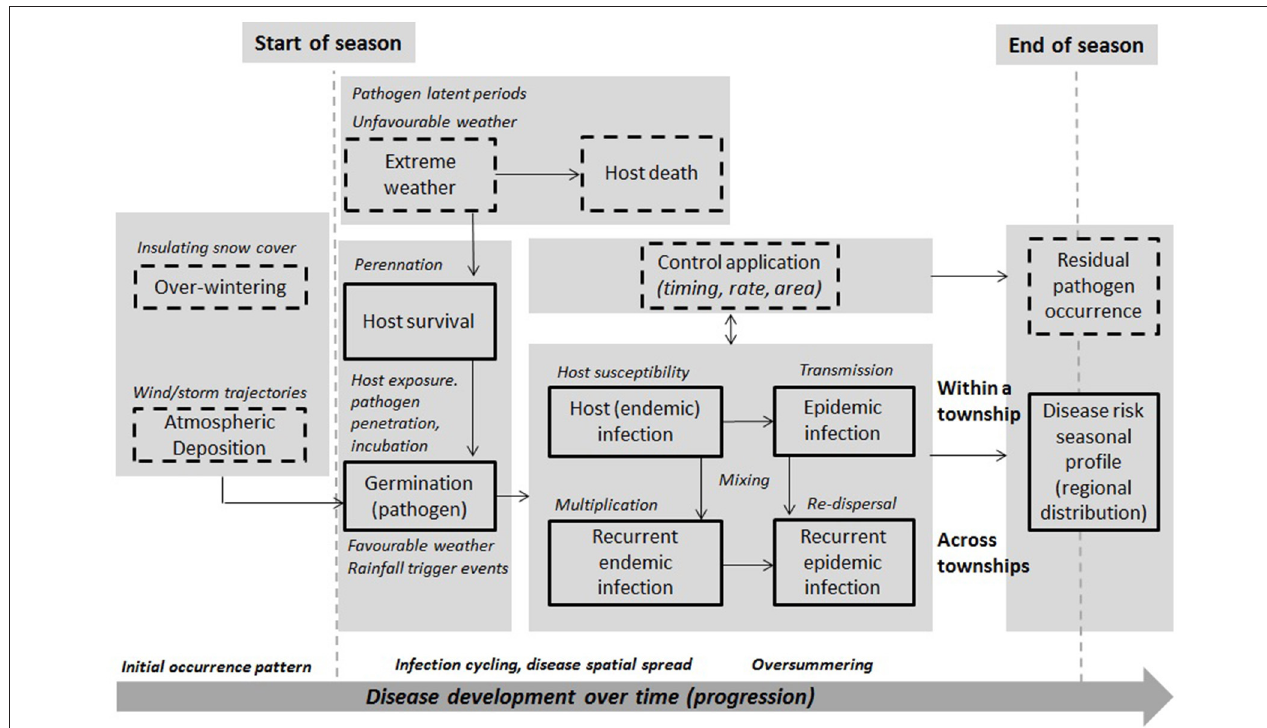
FIGURE 1 | A prototype integrated, model-based framework for forecasting disease risk. Risk components for the major disease progression stages (i.e., immigration, deposition, germination, infection, incubation/residency, multiplication, re-dispersal, perennation) are included, alongside major risk variables, e.g., weather trigger events and conditions, host exposure and susceptibility, pathogen survival, residency, latency, endemic infection, cycling, epidemic transmission and dispersal, and evolved virulence associated with the risk of resistance breakdown in the field (i.e., finer subregions compared to the ROI). Full boxes are components of the framework that are considered in the current disease risk modeling, while dashed boxes will be considered in future extended